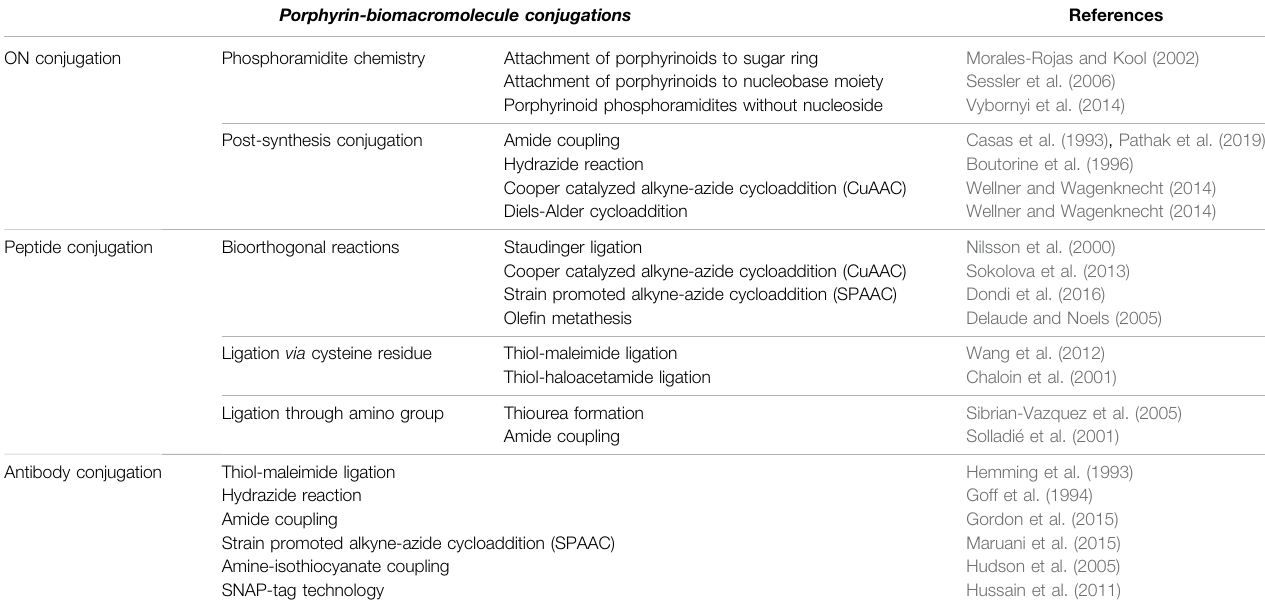
TABLE 1 | Strategies for conjugation of porphyrinoids to key